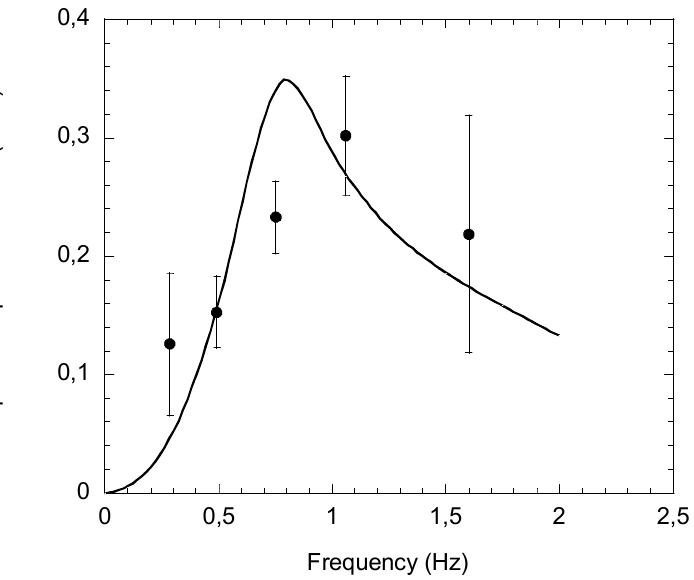
Figure 20. Spatial amplification rate as a function of the imposed perturbation frequency of the rotation velocity of one extrusion screw, ( • ) experimental points (—) convective stability calculations (Reprinted from Ref. [35]).